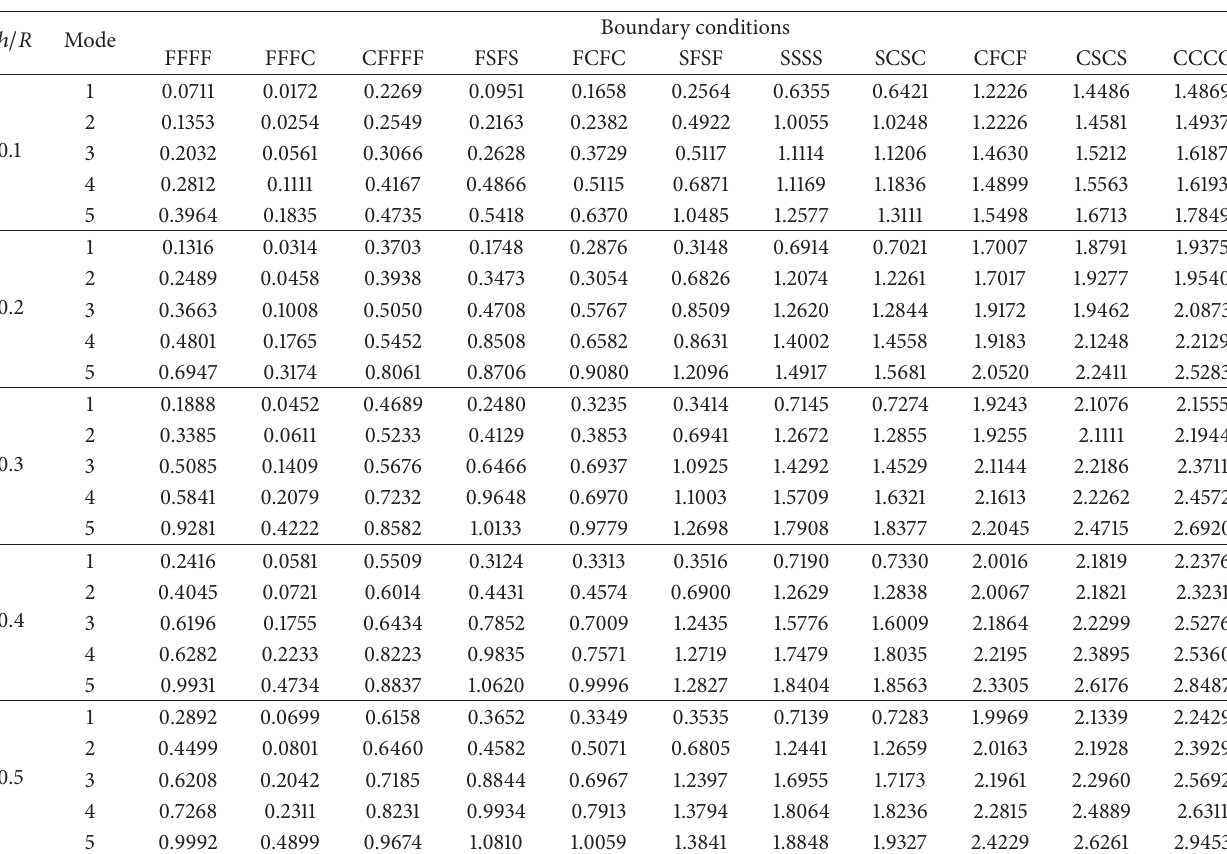
Table 12: The first five frequency parameters Ω = 𝜔𝑅√𝜌( 1 − 𝜇 2 )/𝐸 of an open isotropic spherical shell with various boundary